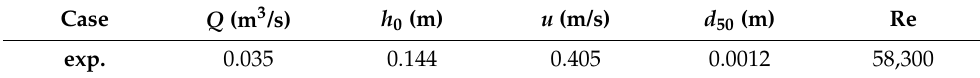
Table 1. Physical experiment setup.